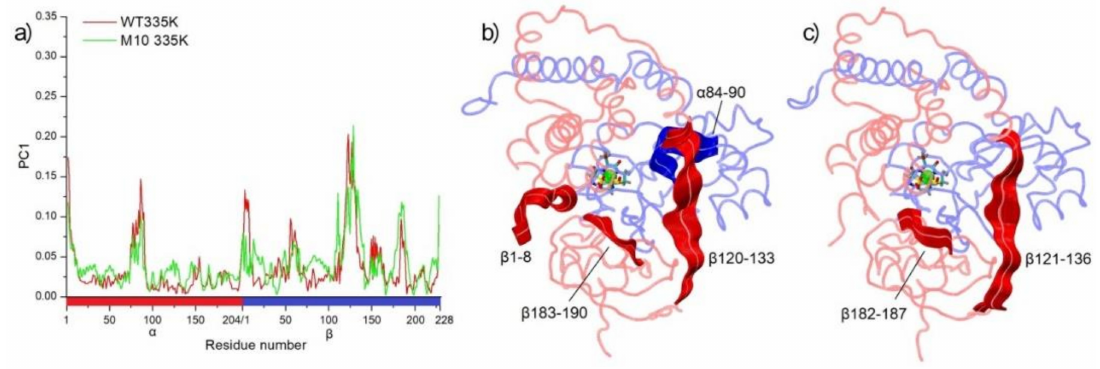
Figure 8. The first principal component (PC1) analysis of MD simulations in 335 K. ( a ) Residue-wise loadings for PC1. Panels ( b ) and ( c ), movements of amino acids with loadings to PC1 bigger than 0.1 for WT and M10,